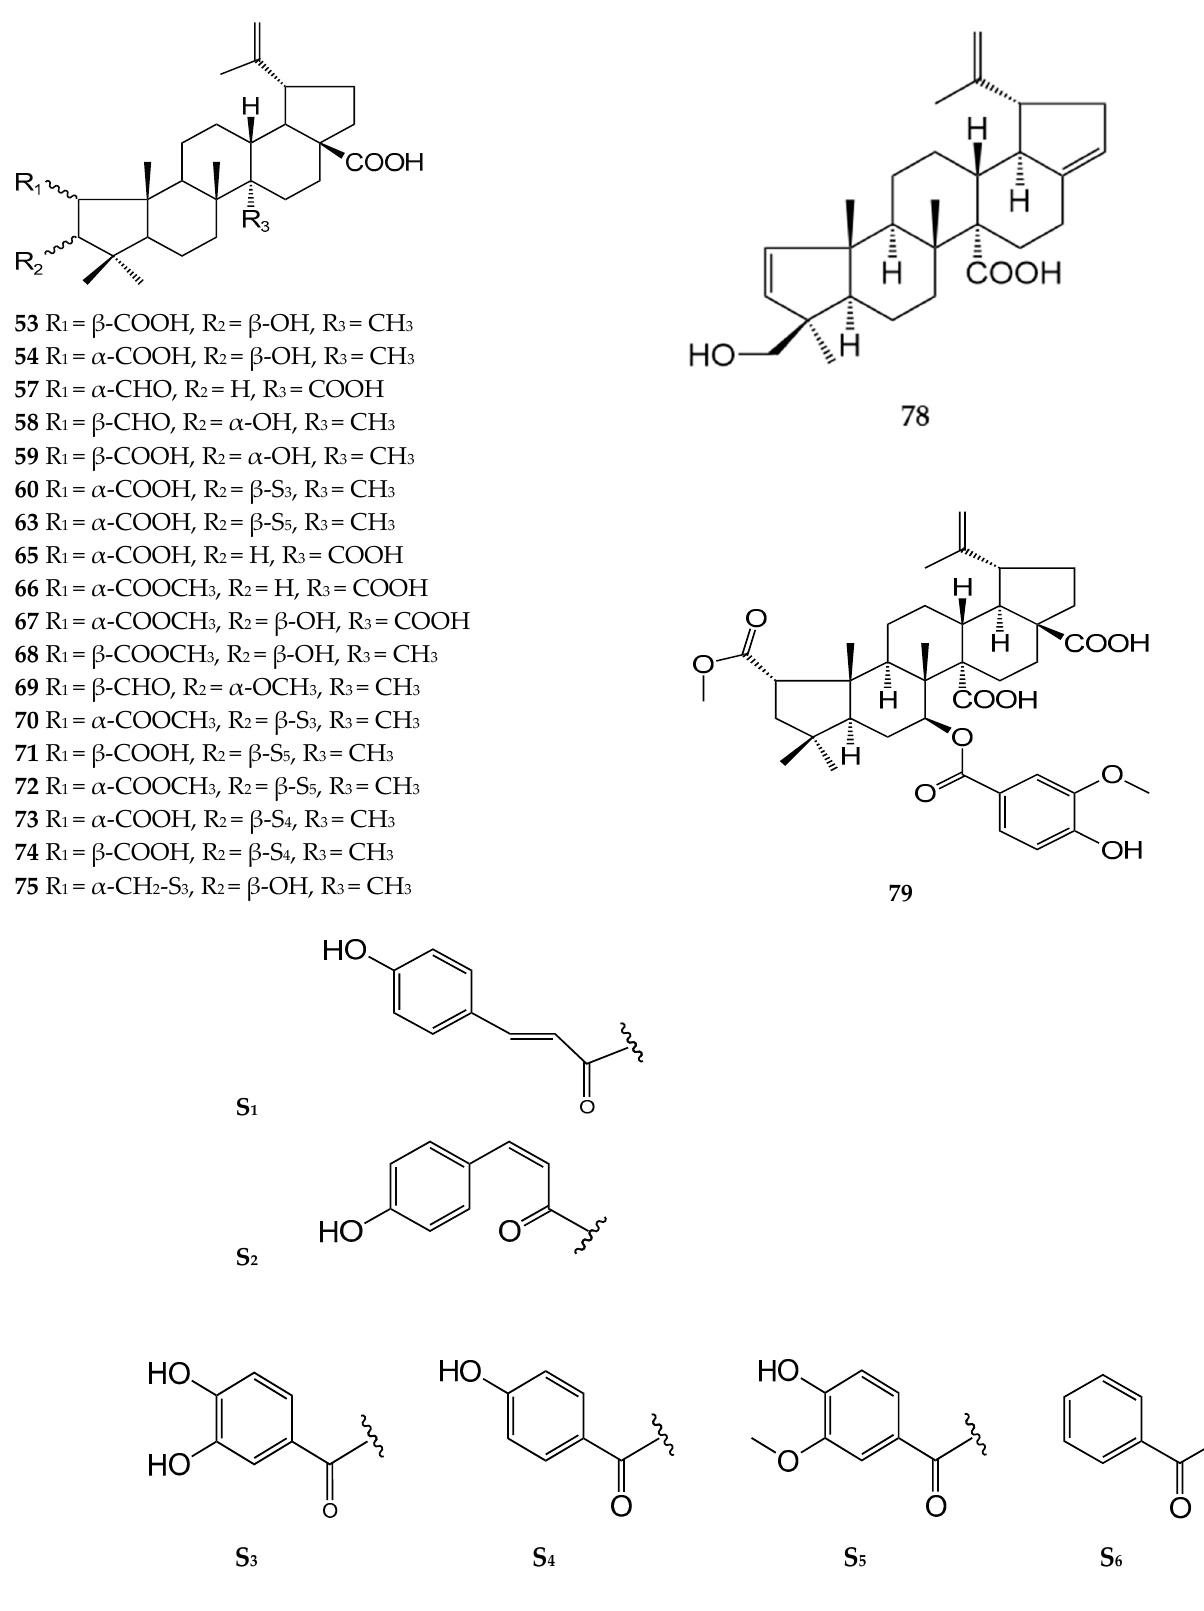
Figure 1. Chemical structures of triterpenoids in ZJ and ZA.